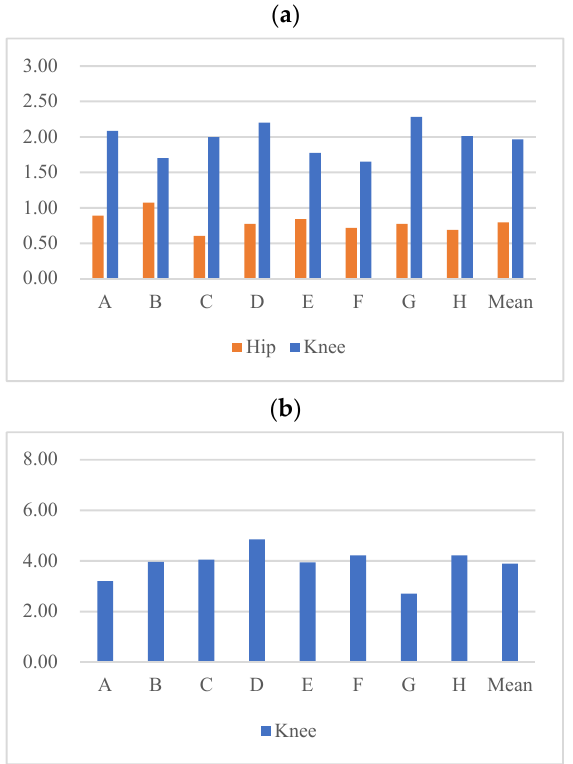
Figure 4. ( a ) RMSE of simulations of hip and knee angles by interlimb LSTM models; ( b ) RMSE of simulations of knee angles by intralimb LSTM models. There is one simulation session for each subject’s data. For example, when estimating subject A’s joint angles, the synergy (interlimb and intralimb) is modeled from the other 7 subjects’ data. “Mean” is the average RMSE of different simulation sessions.